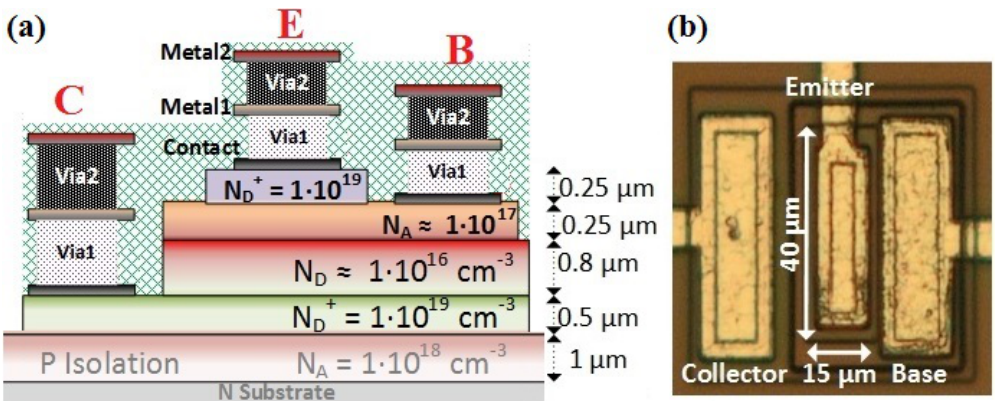
Figure 6. Fabricated n-p-n bipolar transistor ( a ) 2D cross-sectional view, (not to scale) ( b ) micro-photograph of top view.